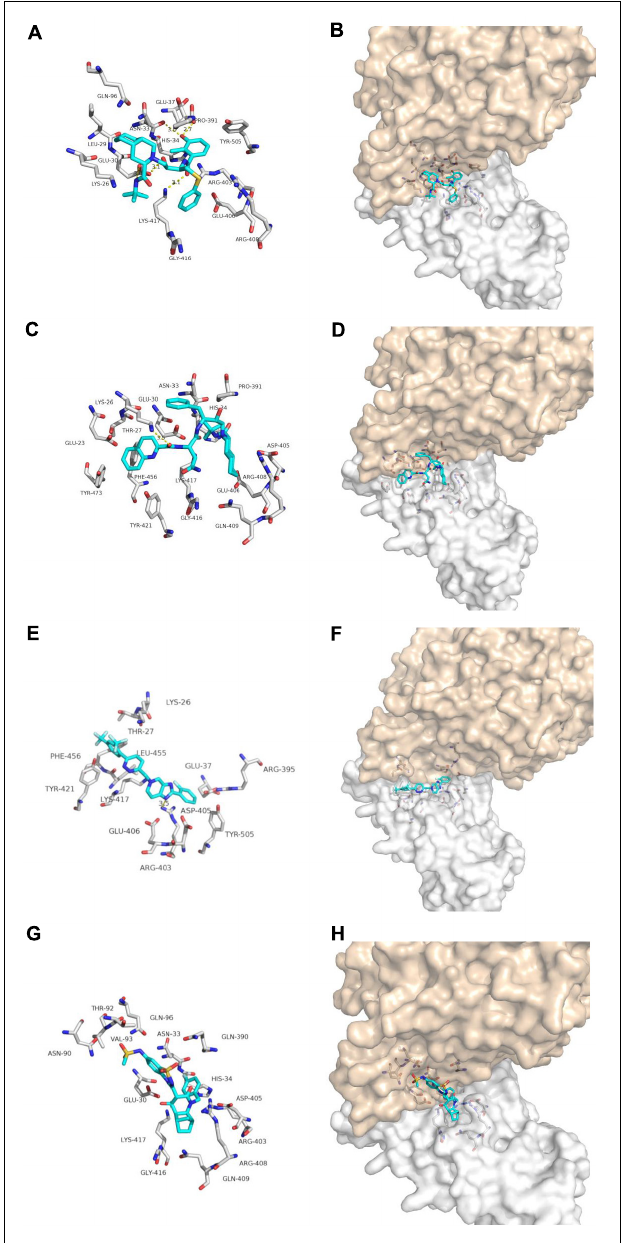
FIGURE 3 | Binding model of antiviral drugs with ACE2 and Spike glycoprotein complex interface. Antiviral drug binding model with ACE2 and Spike glycoprotein complex interface. (A,C,E,G) are the binding models of ACE2 and Spike glycoprotein complexes with antiviral drugs, Olysio (cyan) and related residues (off-white), (B,D,F,H) are compound Olysio (blue). The interaction-green model is located at the interface of the Spike glycoprotein complex (between coffee and white surface). The yellow dotted line indicates the interaction distance (A). (A,C,E,G) or (B,D,F,H) are nelfinavir, saquinavir, tegobuvir, and setrobuvir,